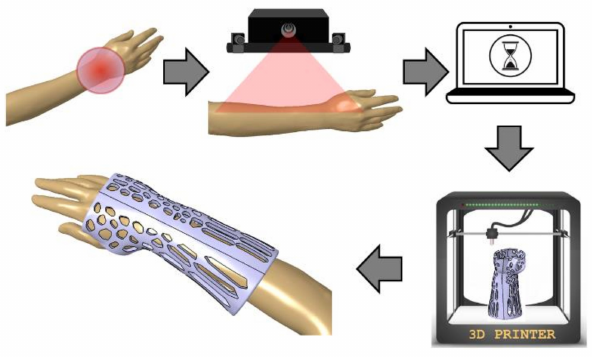
Figure 1. Scheme of work of the proposed AutoMedPrint